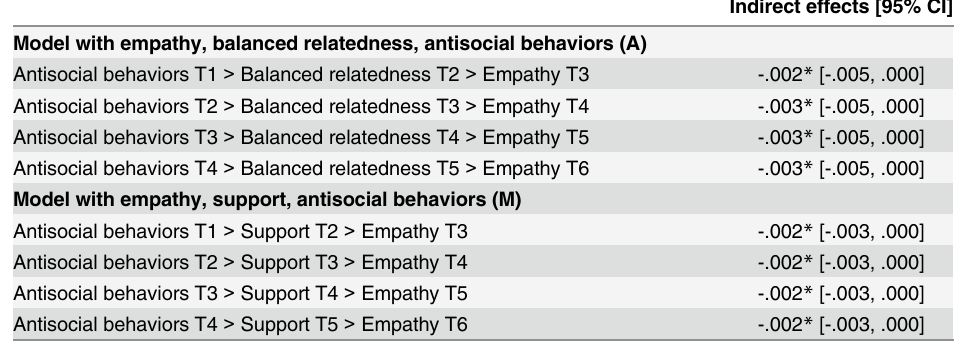
Table 5. Significant Standardized Indirect